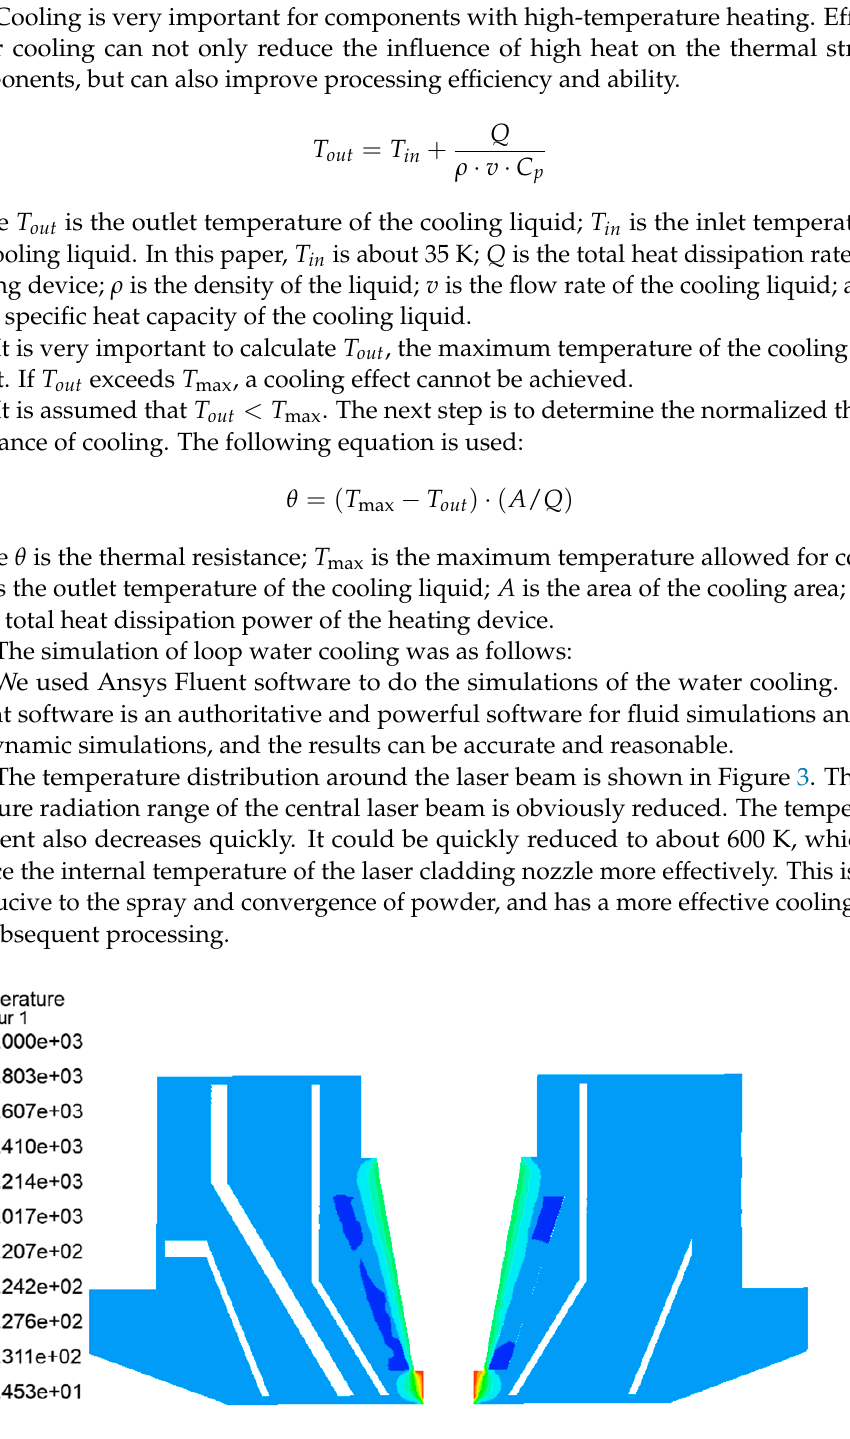
Figure 3. Internal temperature distribution.